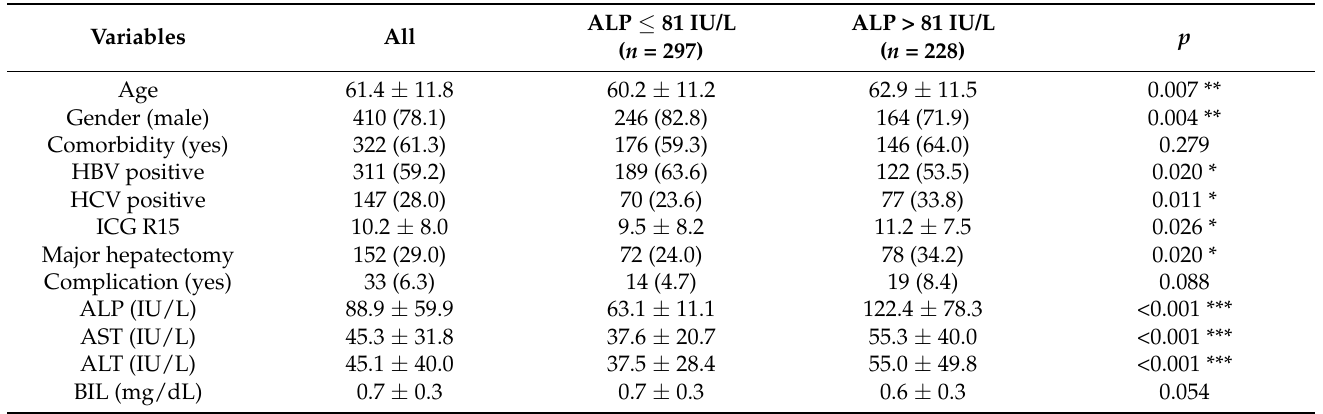
Table 1. Demographic data of 525 HCC patients; comparison of higher and lower ALP